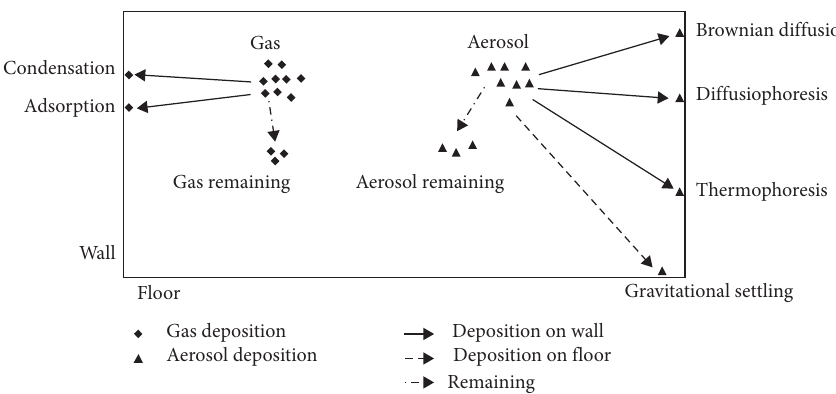
Figure 1: Characteristic of deposition phenomena of gas and aerosol forms in Modified ART Mod